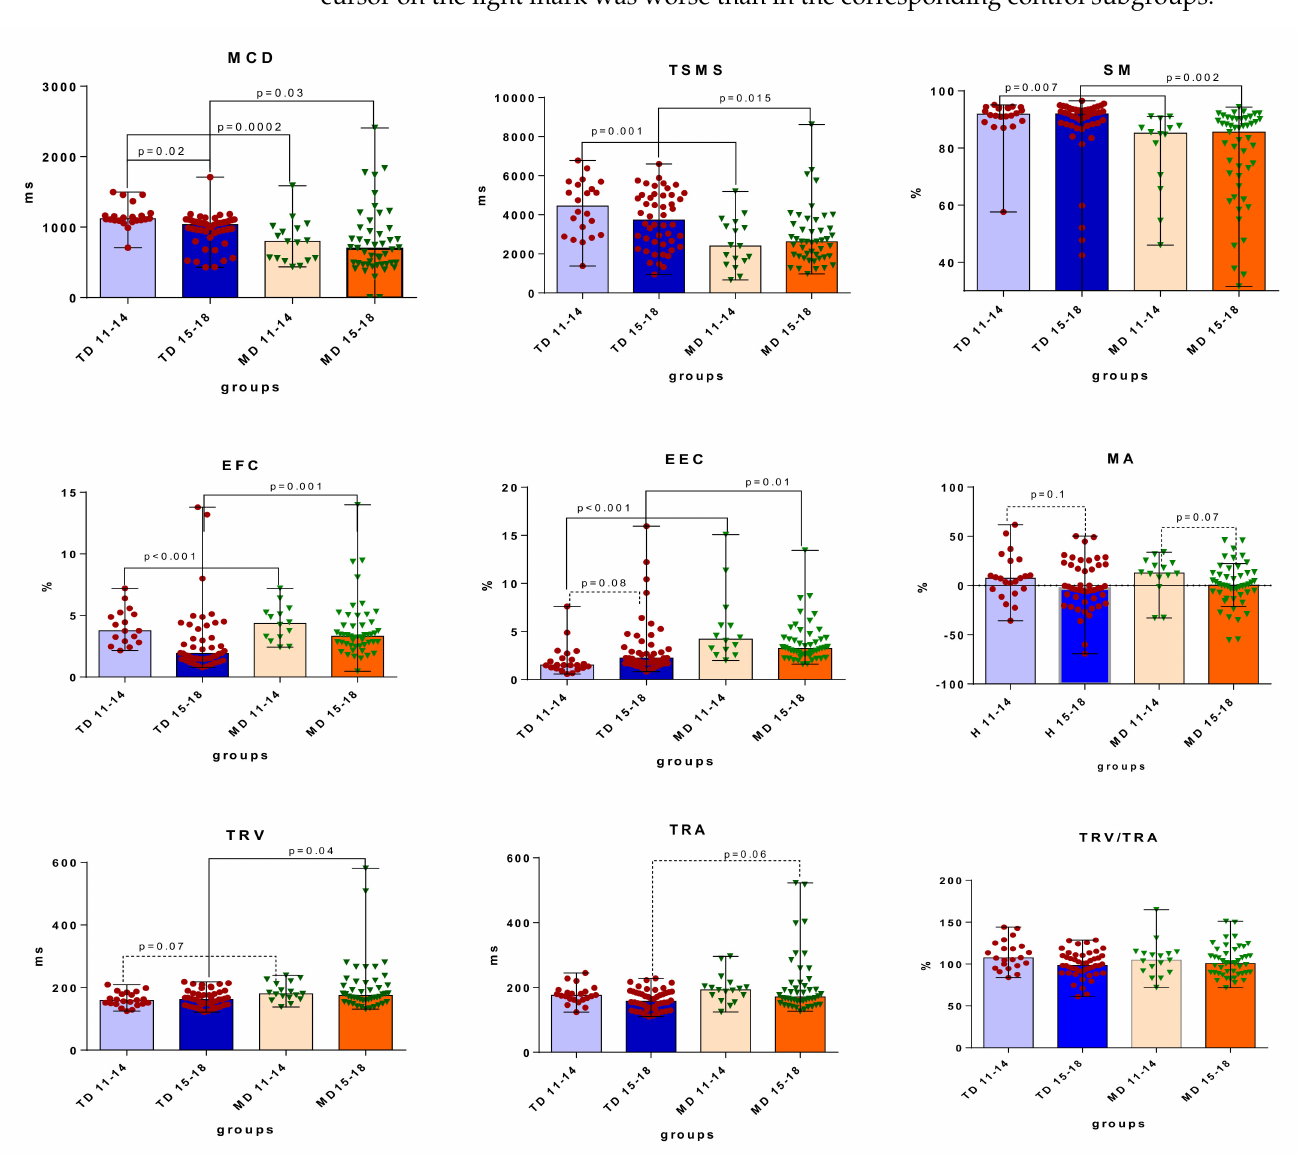
Figure 1. Parameters of psychomotor coordination and simple sensorimotor reaction in the younger (11–14 years) and elder (15–18 years) age subgroups of typically developing adolescents (TD) and adolescents with mental disorders (MD). Kruskal–Wallis test: MCD–H (3, N = 133) = 30.809, p = 0.0000; TCMS–H (3, N = 133) = 23,659, p = 0.0000; SM-H (3, N = 133) = 32.628, p = 0.0000; TRA-H (3, N = 132) = 13.569, p = 0.004; TRV-H (3, N = 133) = 11.707, p = 0.008; EFC-H (3, N = 133) = 34.789, p = 0.0000; EEC-H (3, N = 133) =33.172, p = 0.0000; MA-H (3, N = 130) = 8.314, p = 0.04. Results of post-hoc analysis are shown in Figure